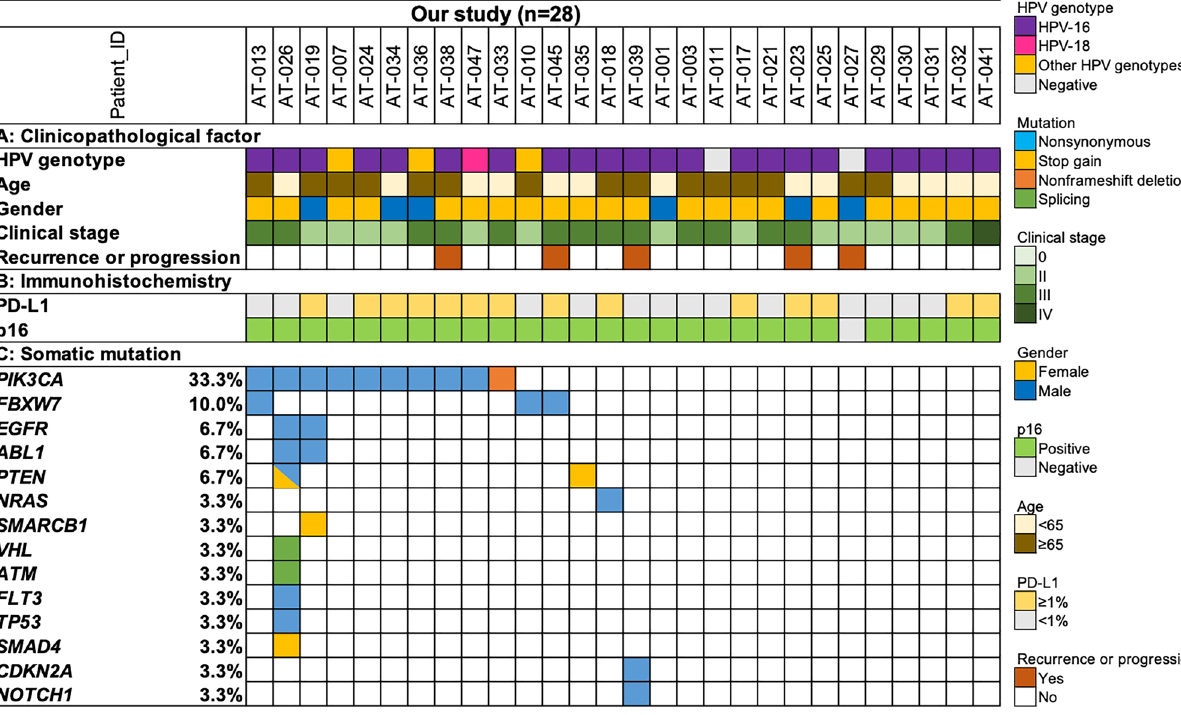
Figure 1. Profile of 28 Japanese patients with ASCC. All panels are aligned with vertical tracks representing 28 patients with ASCC. ( a ) The pattern of clinicopathological factors. ( b ) Evaluation of PD-L1 and p16 expression using IHC. ( c ) Distribution of somatic mutations detected in Japanese patients with ASCC. ASCC, Anal squamous cell carcinoma; IHC, Immunohistochemistry.